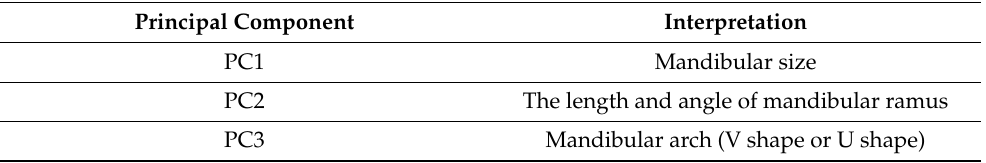
Table 4. Interpretations of distinguishable component in PCA between homologous mandible model in total mandible.